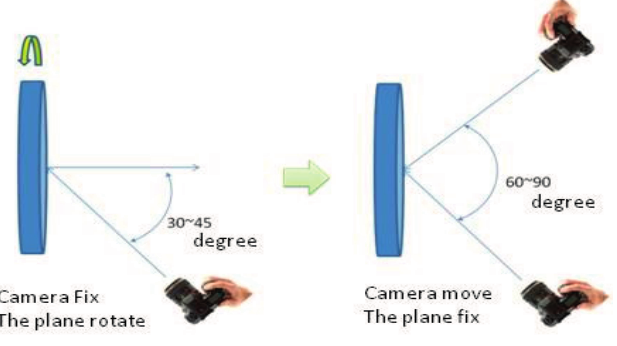
Figure 12. Relation between two